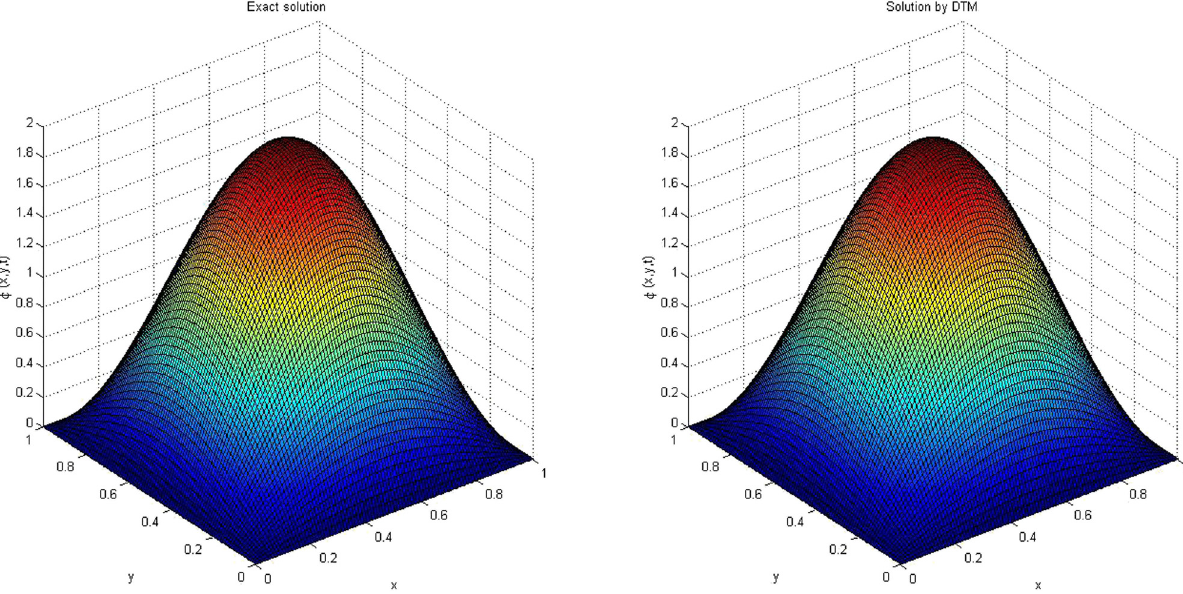
Figure 2: Comparison of obtained and exact solution due to D ( TQ ) M of the di ff usion equation with M N 101 = = , ρ 1 = , and T 1 = .